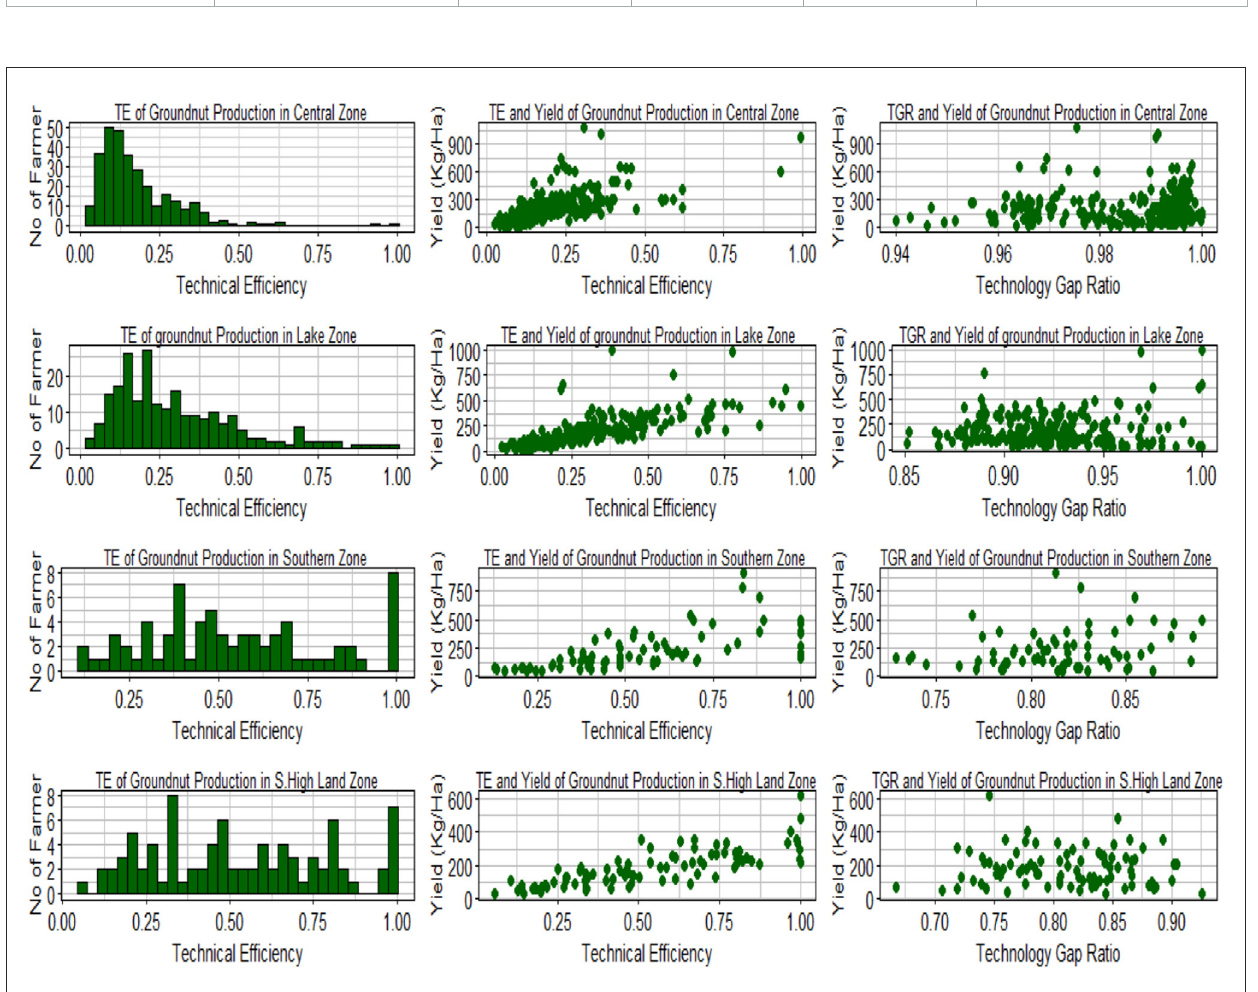
FIGURE2 Distribution of technical efficiency (TE) and technical gap ratio